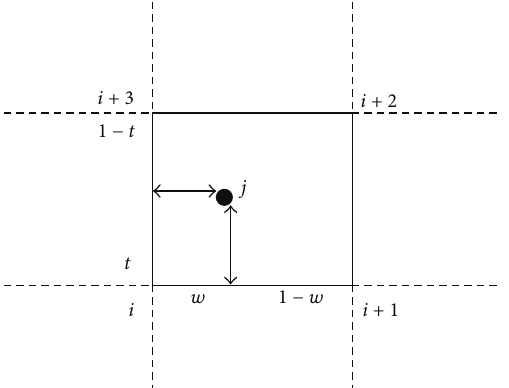
Figure 2: Bilinear interpolation. The weights 𝑤 and 𝑡 are the dis- tances between the station 𝑗 and the grid point 𝑖